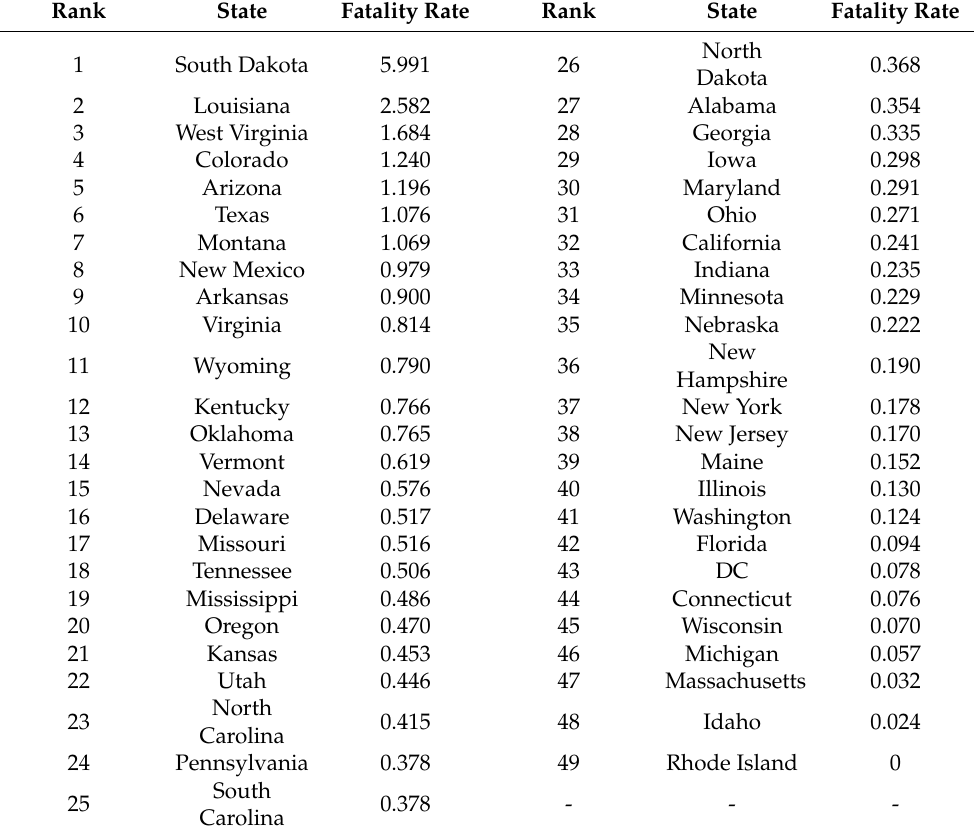
Table 2. Average annual fatality rates per one million persons of the 48 contiguous states and DC and their ranks